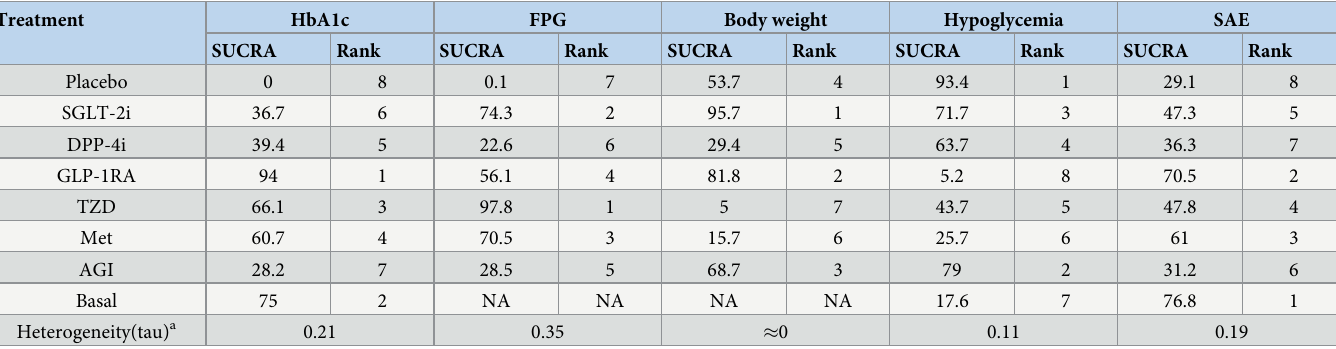
Table 3. The results of the surface under the cumulative ranking curve (SUCRA) ranking probabilities. Treatment